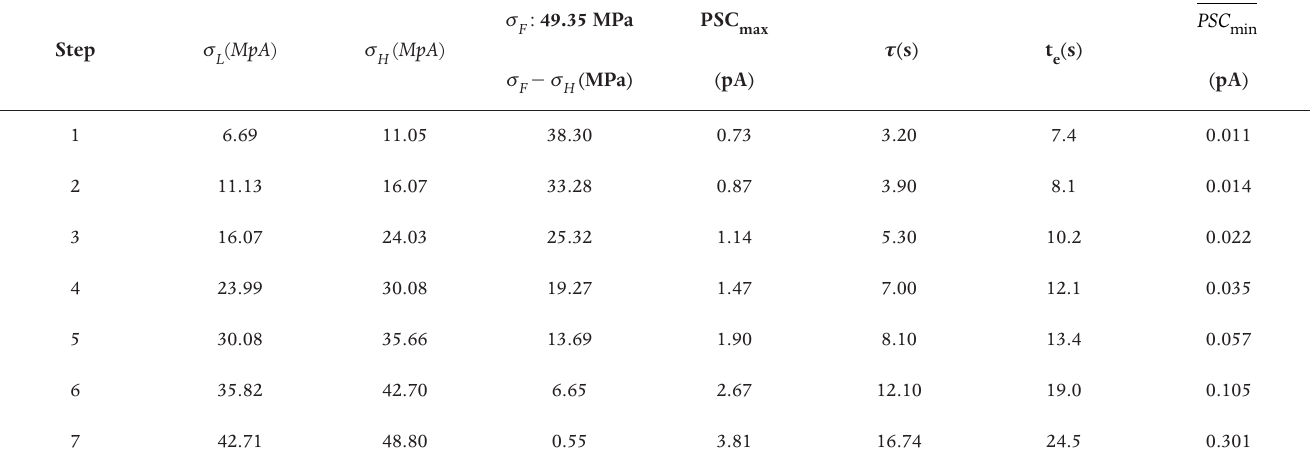
Table 1. The v and v levels of the seven sequential stress steps, with the corresponding values of the macroscopic characteristics of the PSC L H signals